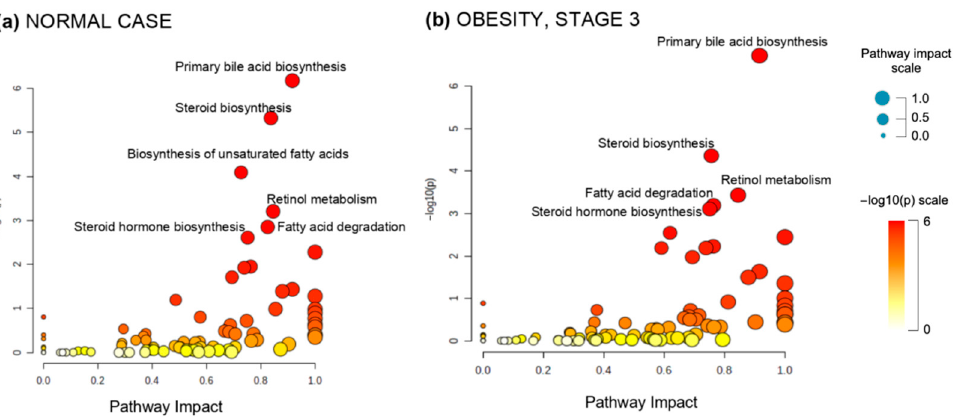
Figure 4. Metabolomic pathways profiles produced using Pathway Analysis module of MetaboAna- lyst 5.0 web-platform: ( a ) normal—20 samples ( b ) third stage obesity—20